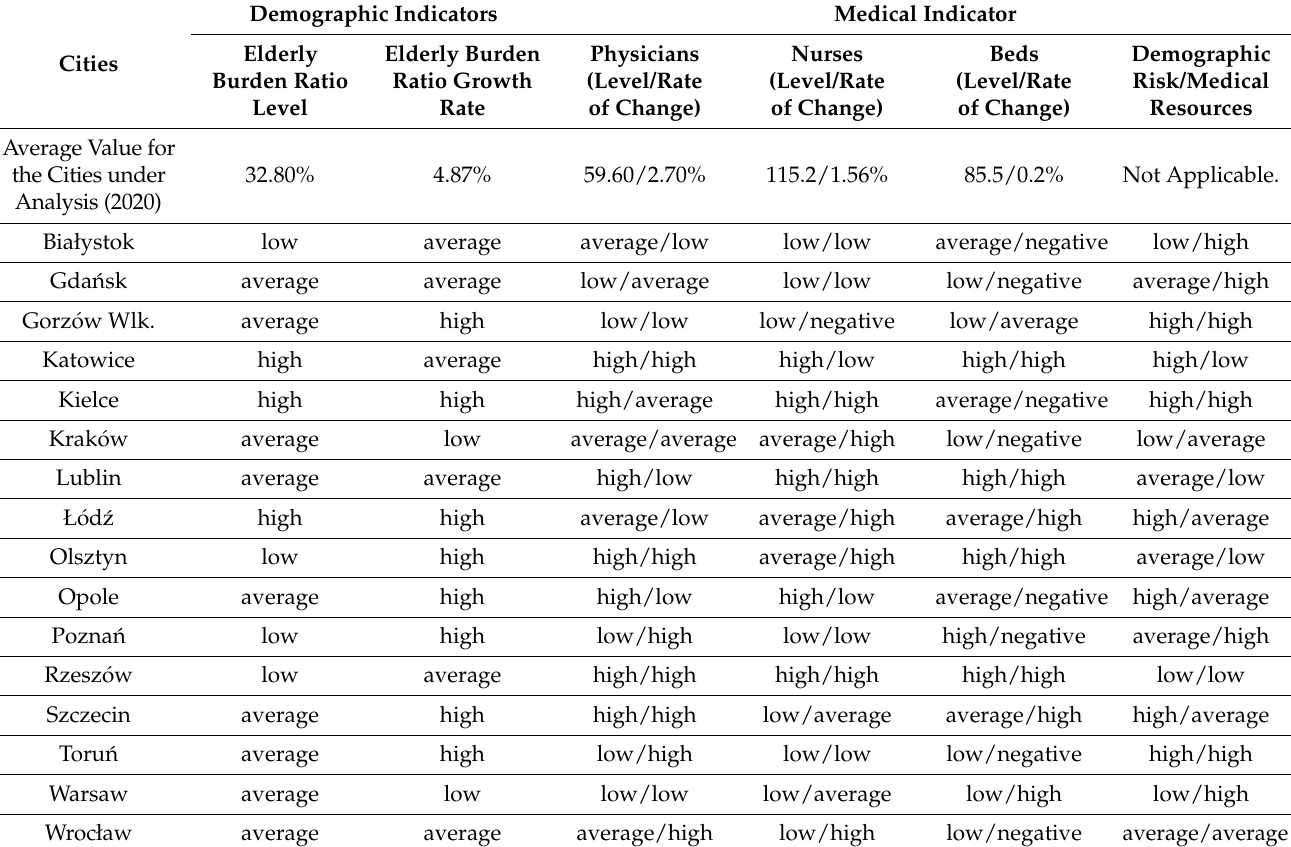
Table 4. Summary of demographic and medical assessment of the surveyed